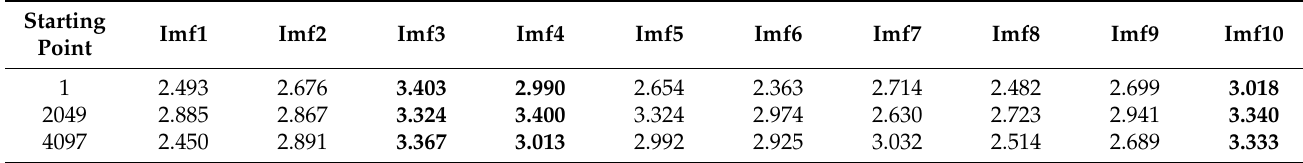
Table 5. The kurtosis value of each mode of the rolling element fault.